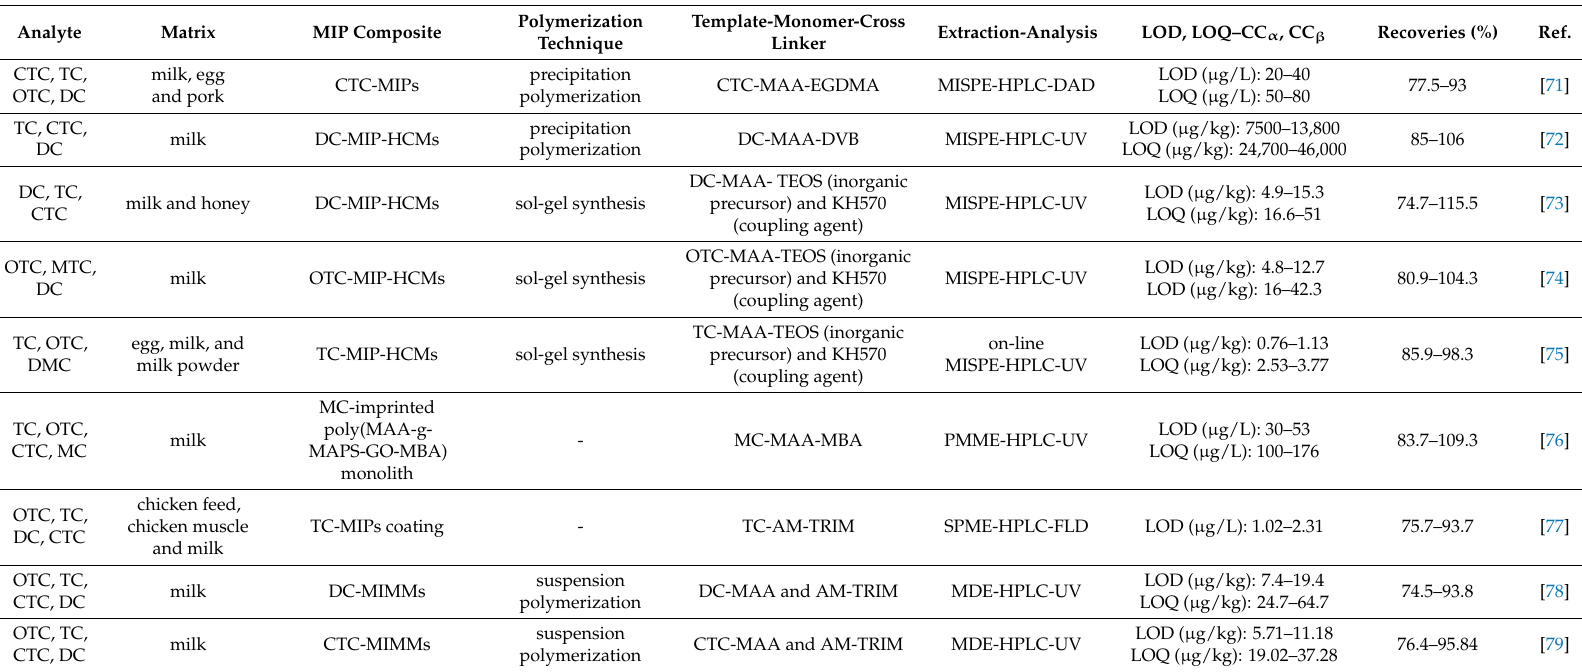
Table 4. MIPs applications for the determination of tetracyclines in milk